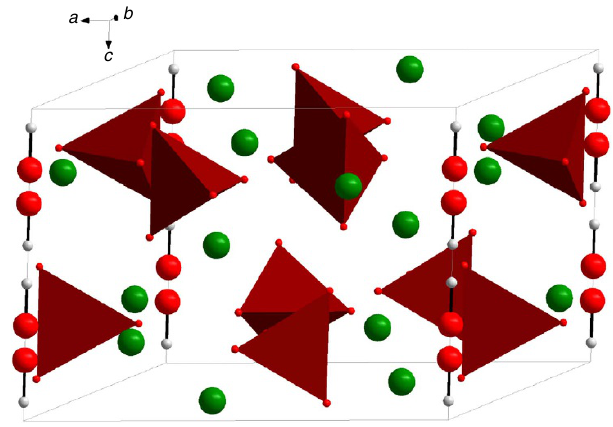
Figure 1 | Representation of the unit cell of hexagonal HAp, Ca 10 (PO 4 ) 6 (OH) 2 . Columns of OH (cid:2) (A-sites) are represented vertically ( c axis) (Ca in green, O in red, H in white, PO 4 tetrahedra in brown). ICSD-26204: Hollysprings hydroxyapatite, showing the orientational disorder along the OH